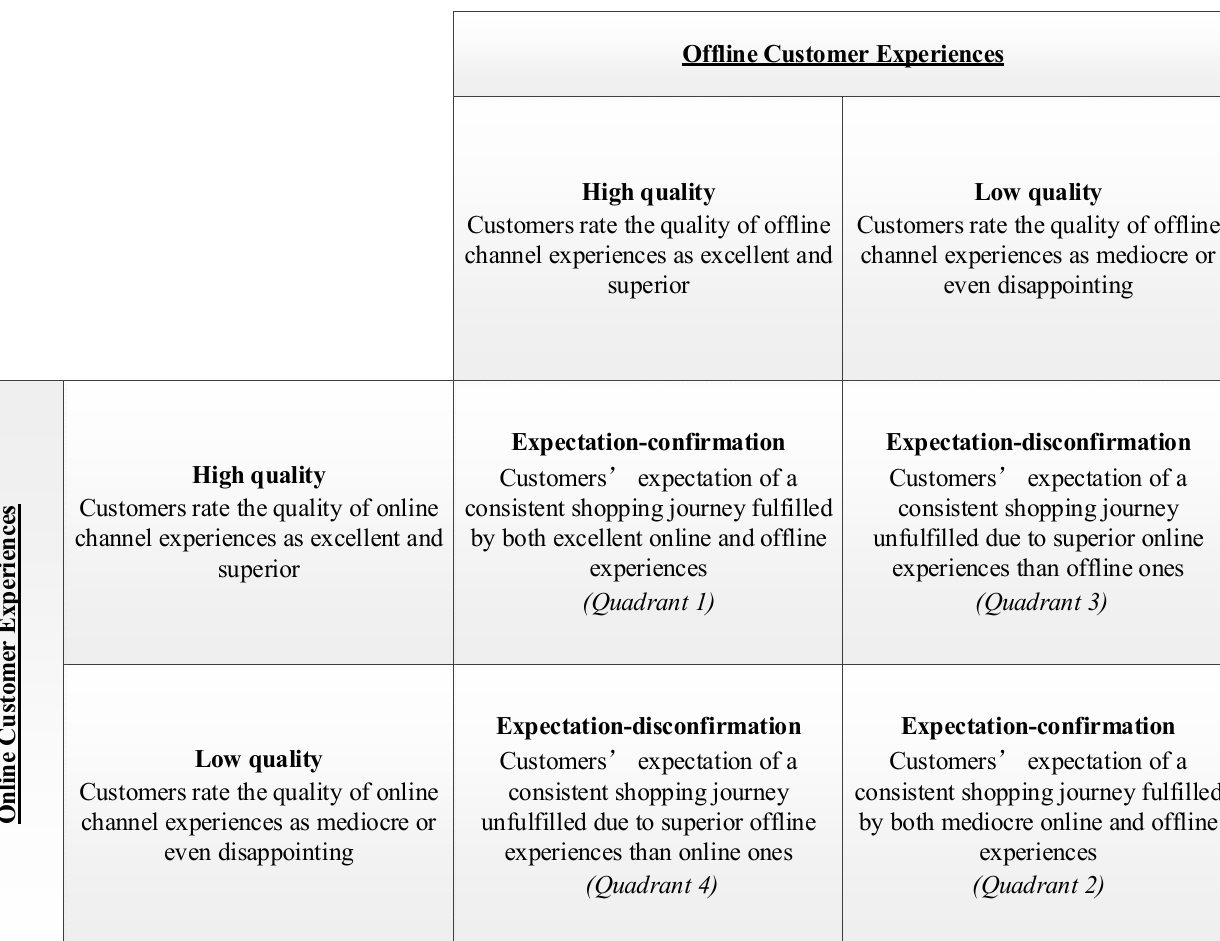
Figure 2. Two-by-two matrix juxtaposing qualities with sources of customer